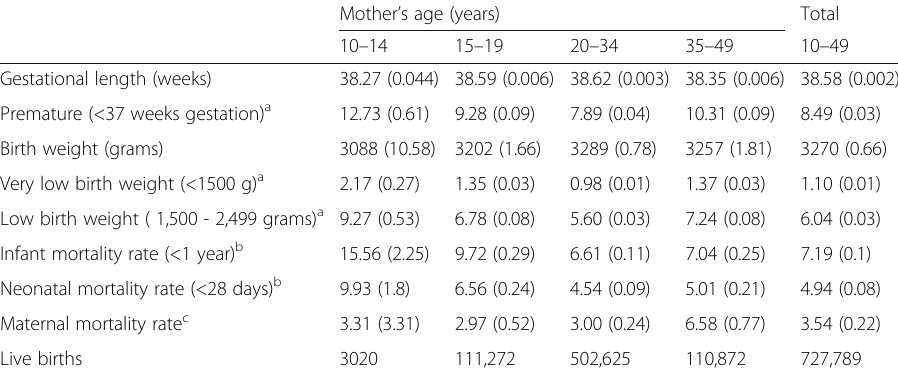
Table 1 Health and demographic indicators by age of the mother. Argentina,